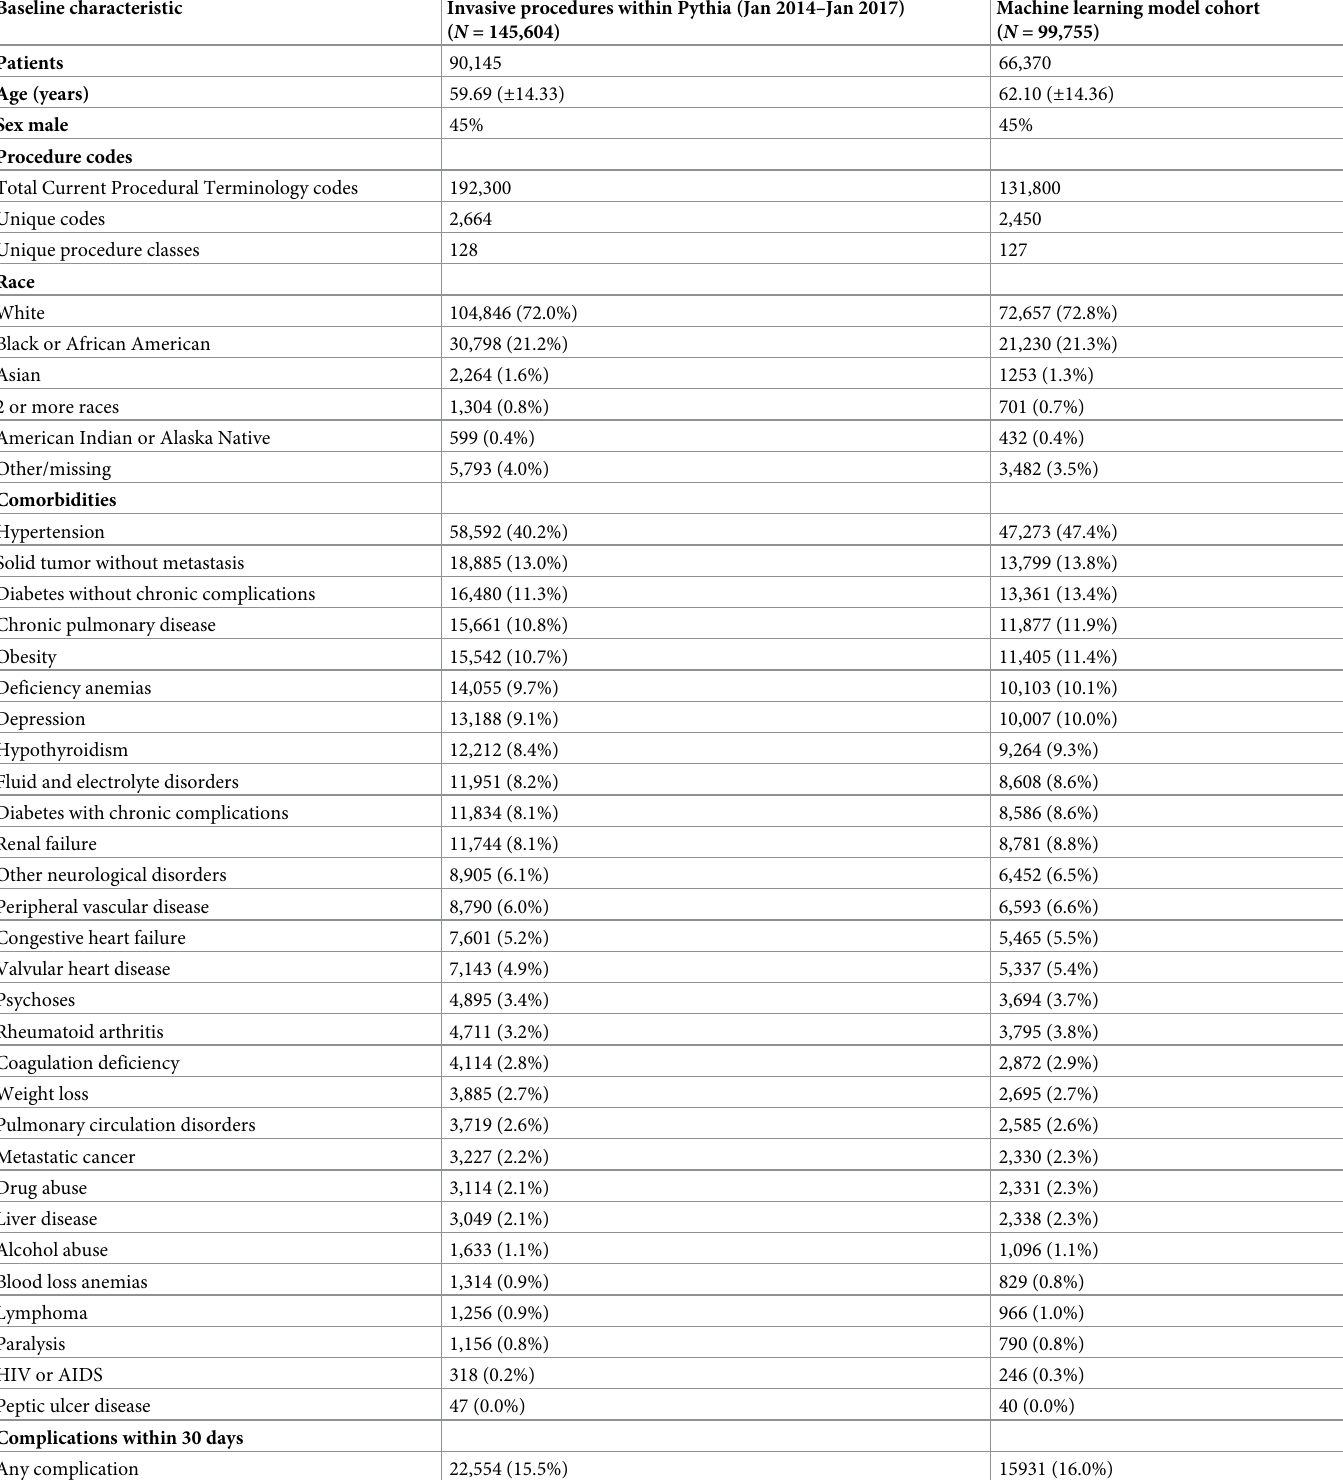
Table 1. Baseline and clinical characteristics of invasive surgical